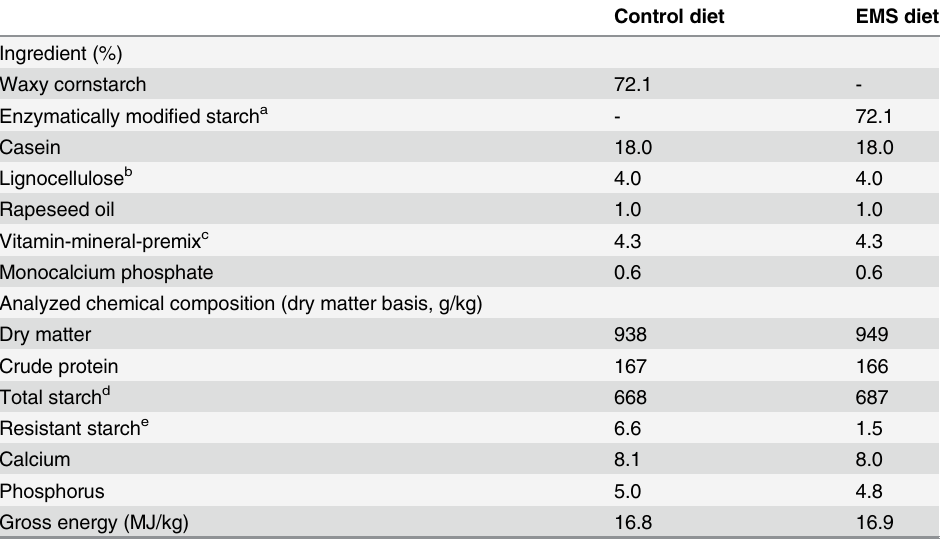
Table 1. Ingredients and analyzed chemical composition of the experimental diets.